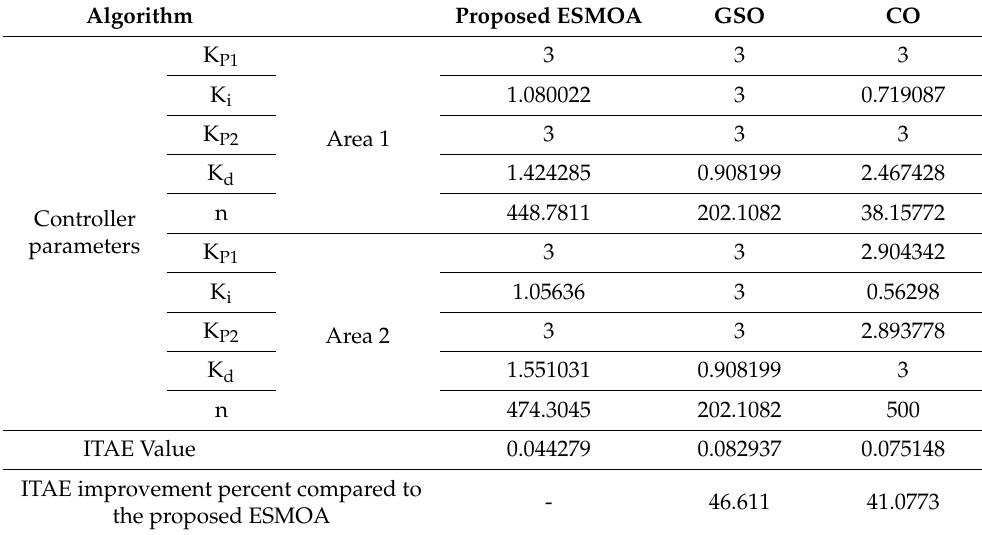
Table 7. Results for Case